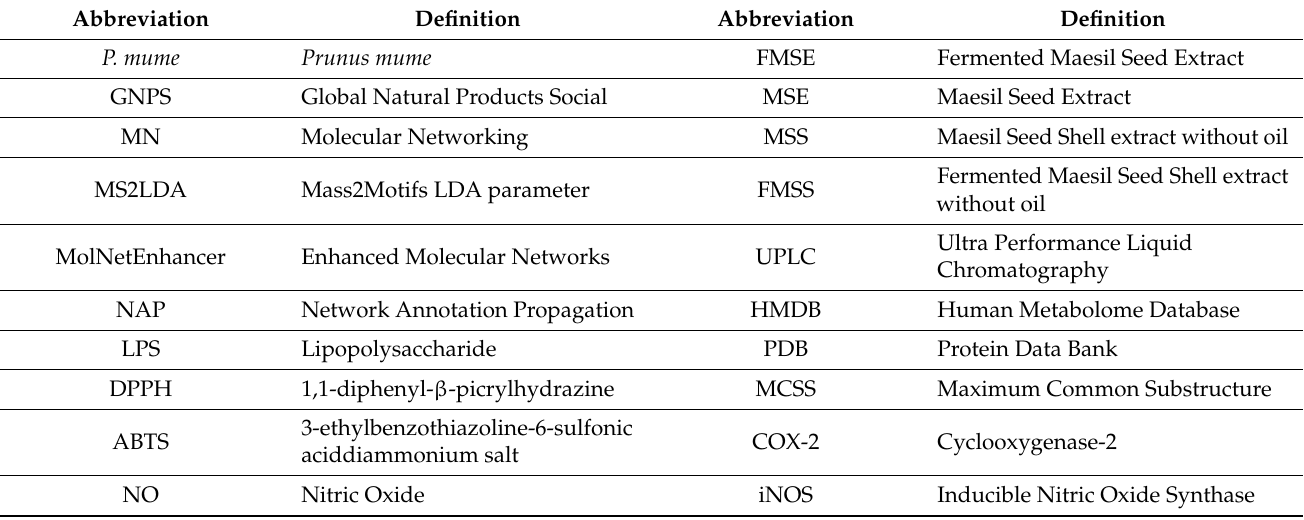
Table 1. List of abbreviations and acronyms used in the